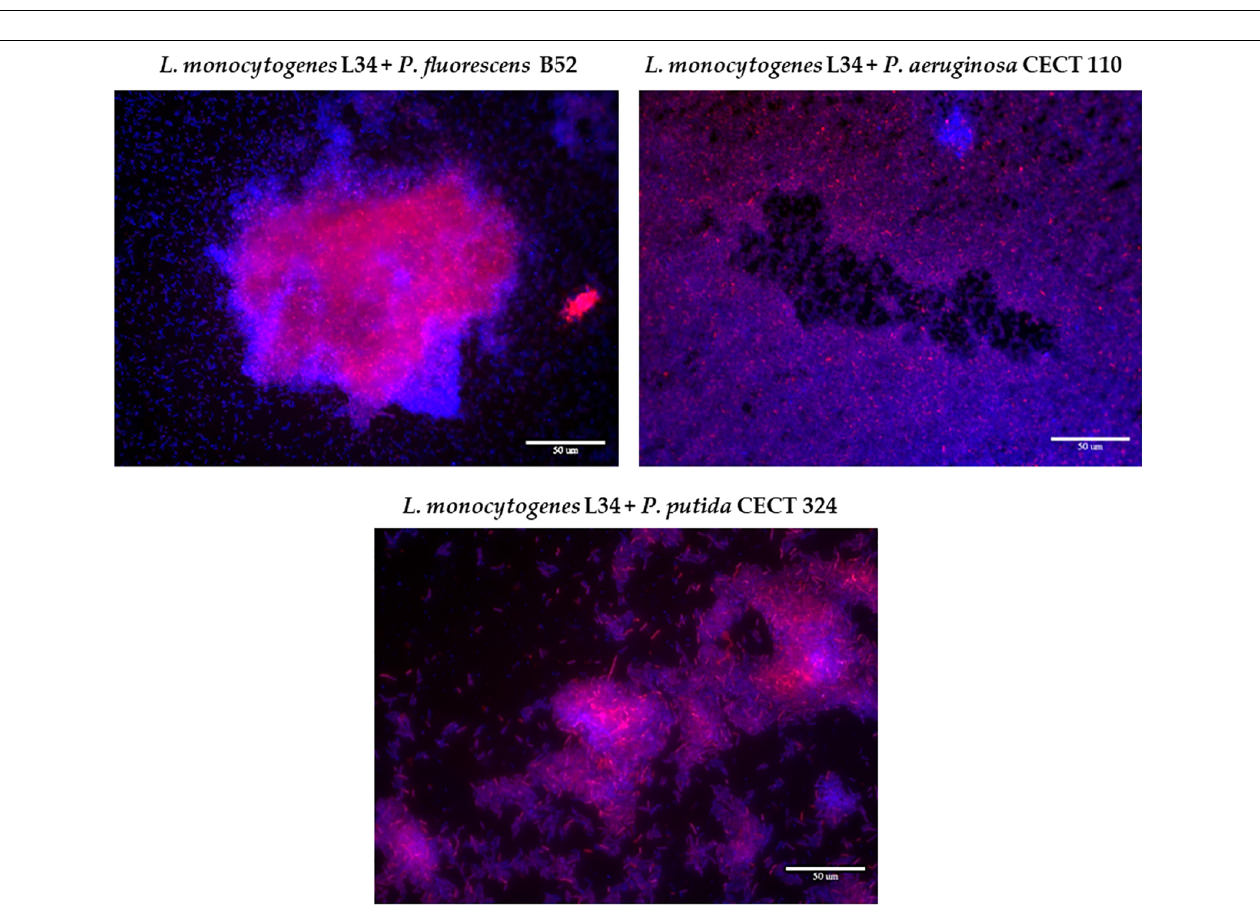
FIGURE 3 | Representative epifluorescence 63 × -field overlay images of the three dual-species biofilms assayed in this study, stained with ViaGram TM Red + Bacterial Gram Stain (ThermoFisher). Red signal: Listeria monocytogenes L34. Blue signal: Pseudomonas spp. Scale bar, 50 µ m.